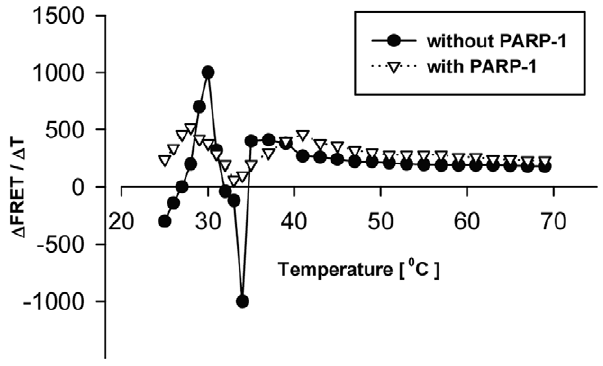
Figure 4. PARP-1 modifies the effect of increasing temperature on the FRET activities of the F- c-myc GQ-R molecule. FRET melting curves were taken in the absence or in the presence of 1 m g h PARP-1 and using a 2 u C/2 min temperature gradient. Excitation was at 485 nm and emission was recorded at 585 nm. From the recorded data D FRET/ D T values were calculated and plotted (ordinate) versus the applied temperatures (abscissa). doi:10.1371/journal.pone.0042690.g004 PLoS ONE |